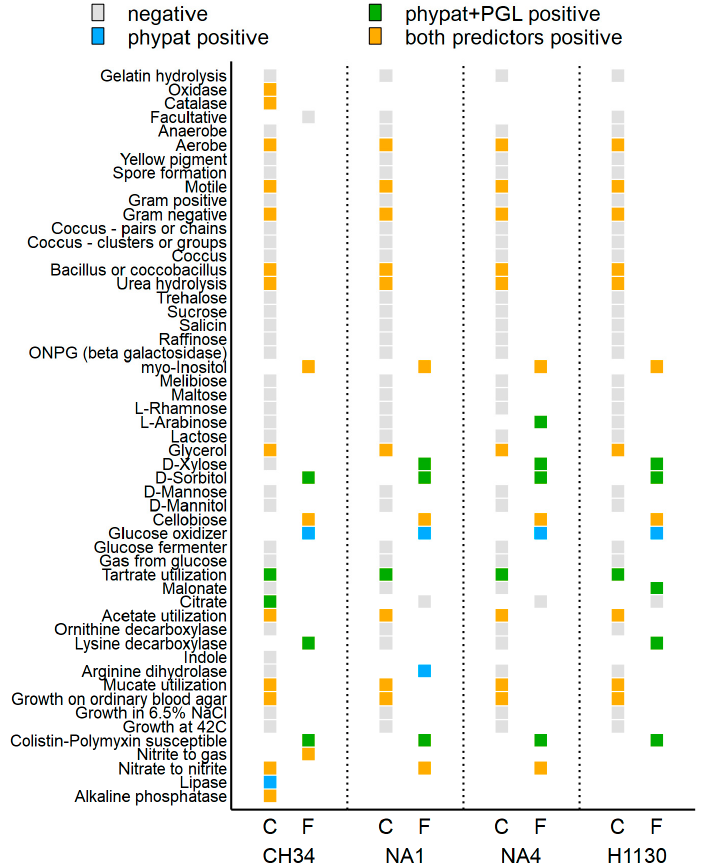
Figure 16. Overview of the correctly (C) and falsely (F) predicted phenotypic traits of C. metallidurans CH34, NA1, NA4 and H1130 by Traitar (two classifiers: phypat and phypat + PGL).